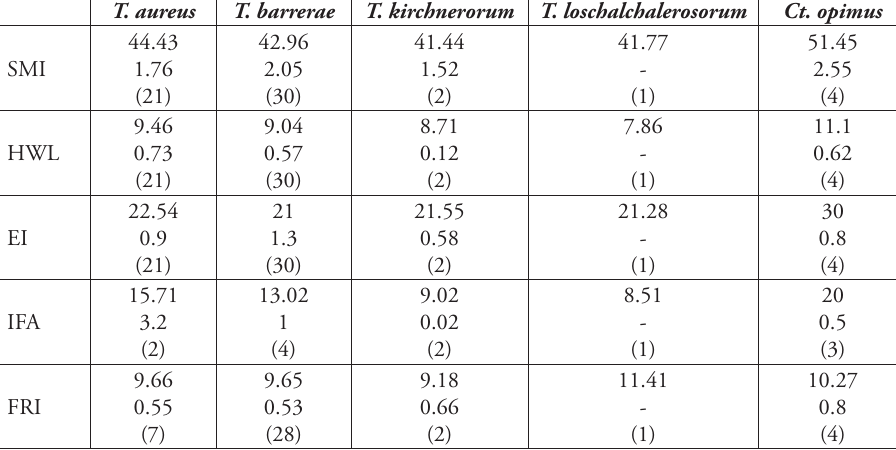
Table 1. Mean, standard deviation, and number of specimens in brackets are indicated for each index and species. T.